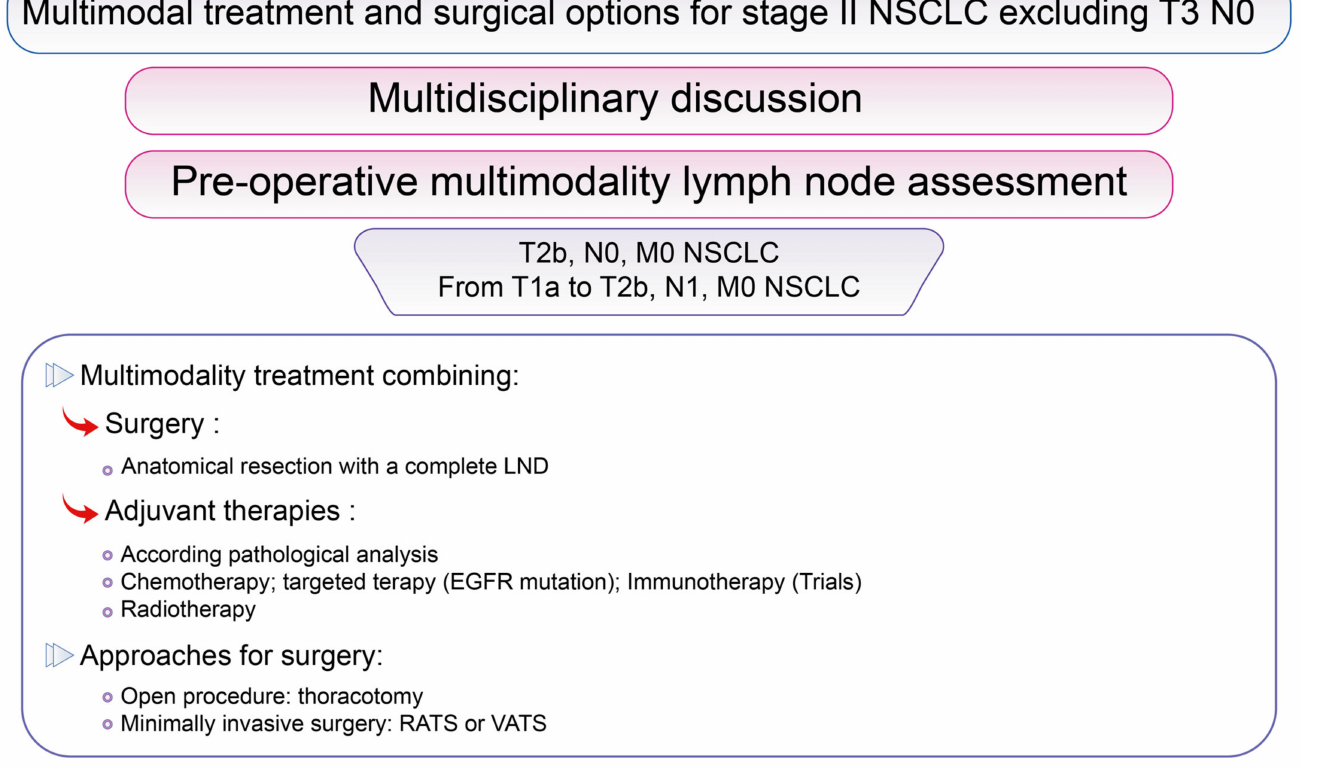
Figure 5. Multimodal treatment and surgical options for stage II NSCLC excluding T3 N0. Surgical options according to lung cancer stage in the lung cancer Stage II group excluding T3 N0, according to the 8th Edition of the TNM classification of Lung Cancer